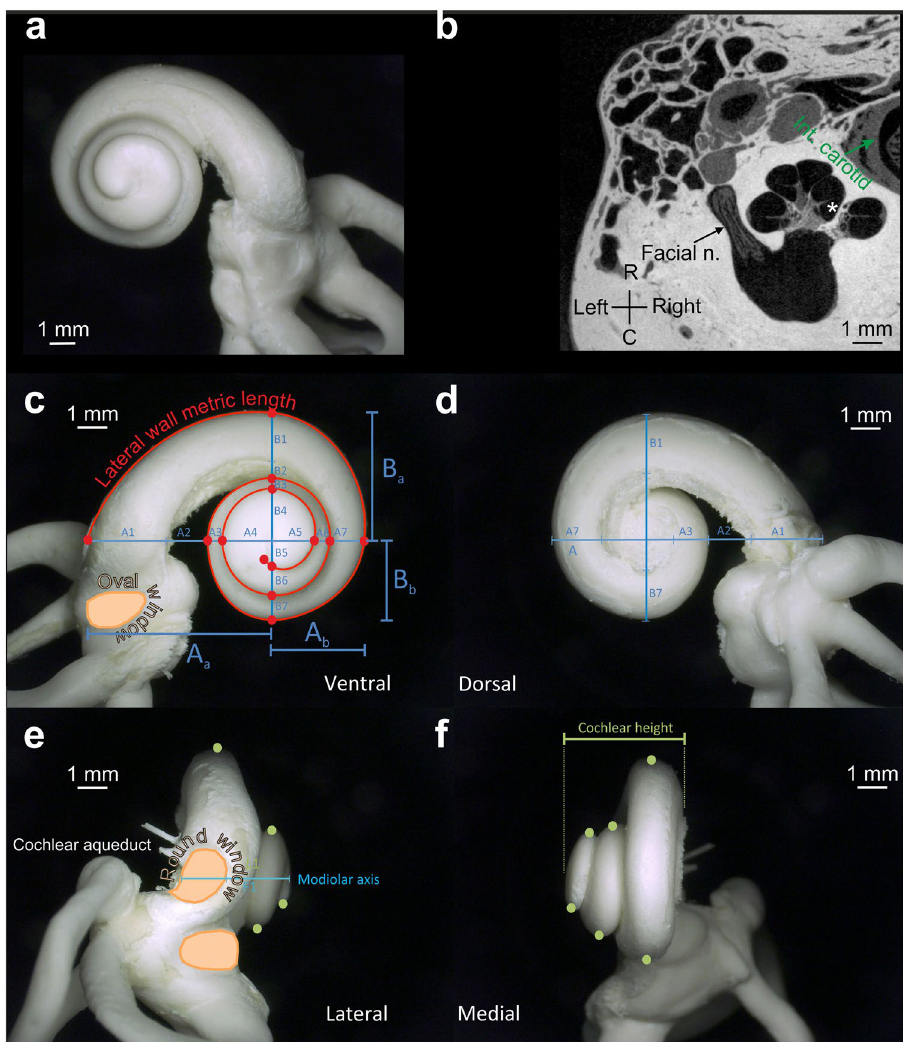
Figure 1. Quantification of cochlear geometry. ( a ) Corrosion cast of a human cochlea photographed through the microscope, view from the apex (rostral view). ( b ) Modiolar section of the human cochlea ( µ CT imaging). In addition to the cochlea, the facial nerve and the internal carotid artery are also visible in these images. Asterisk denotes the scala tympani of the second cochlear turn, R = rostral, C = caudal. ( c ) Rostral view of a corrosion cast and the main parameters (measuring points marked by red dots) further discussed in the present study. Oval window is discernible in this view (orange color). Red line marks the cochlear length along the lateral wall (metric length). Cochlear axes (A and B, sometimes called cochlear base length and width) were determined from the sum of 7 subcomponents. Their mutual intersection defines the parts A a and A b (and B a and B b , respectively). ( d ) Caudal view of a corrosion cast and the parameters quantified in these photographs. These measures were validating the measures in ( c ) and the corrections for tilt of the modiolar axis. ( e ) Lateral view of the cochlea; the green dots mark the points determined for calculation of the height profile. These measures were further corrected for the individual deviation of the modiolar axis from 0°. Round and oval window are discernible in this view (orange colors). ( f ) Medial view of the cochlea; the green dots mark the points determined for calculation of the height profile. Cochlear height was the shortest distance between the apicalmost and basalmost point of the cochlea. All measurements were corrected for the individual deviation of the modiolar axis from